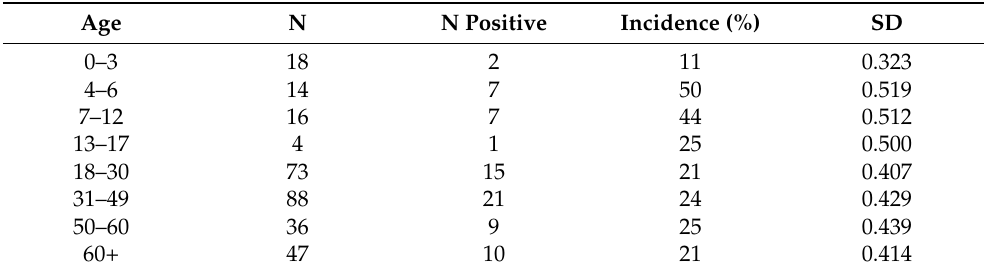
Table 2. Descriptive summary of incidence and proportion of colonized individuals in all age categories detected by qPCR. (N—number of samples obtained; N positive—number of positive samples in qPCR; SD—standard deviation).